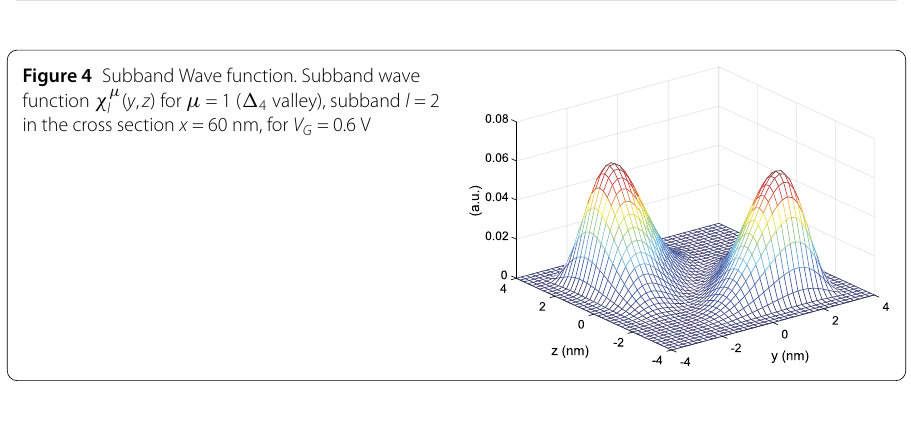
Figure 5 Subband Wave function. Subband wave function χ μ